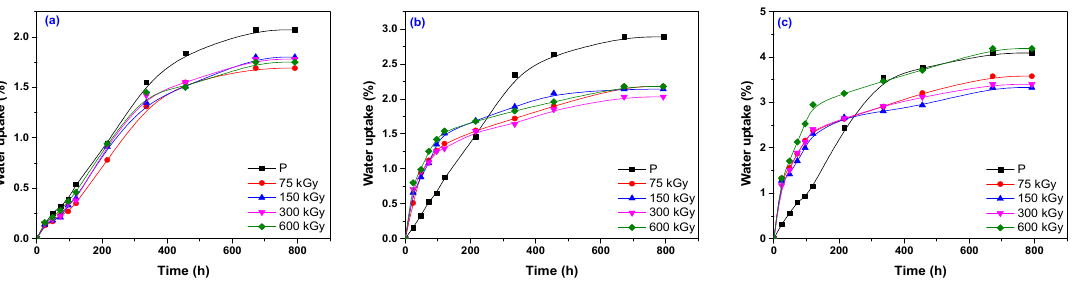
Figure 11. EPDM ( a ), EPDM-S 5 ( b ), and EPDM-S 15 ( c ) water uptake behavior as a function of immersion time.